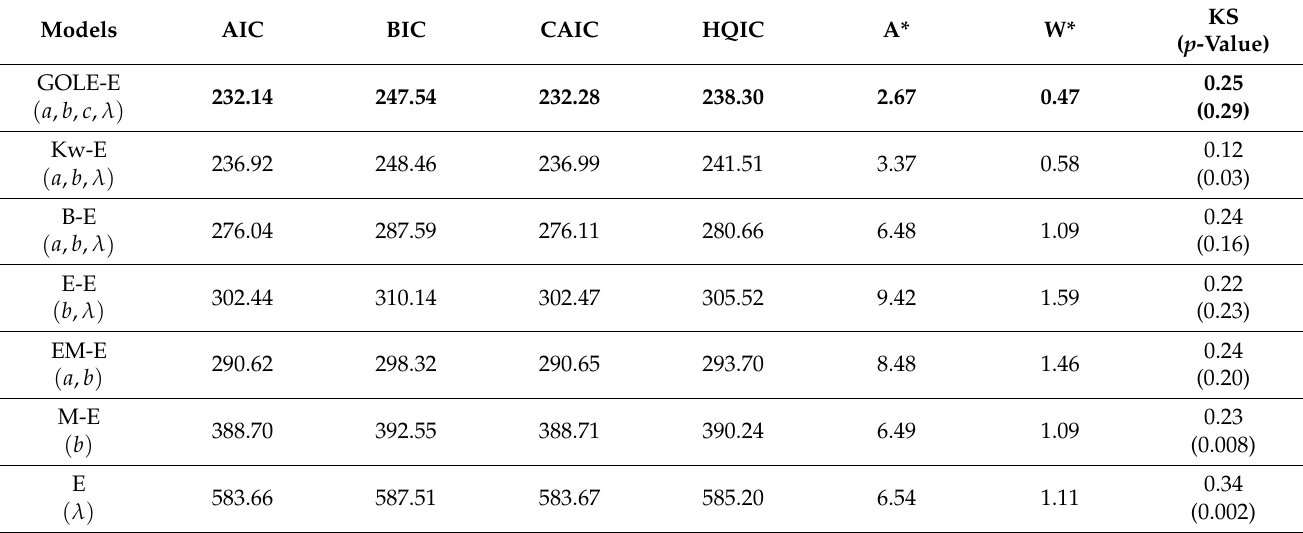
Table 4. The AIC, BIC, CAIC, HQIC, A*, W* and KS ( p -value) values for data set